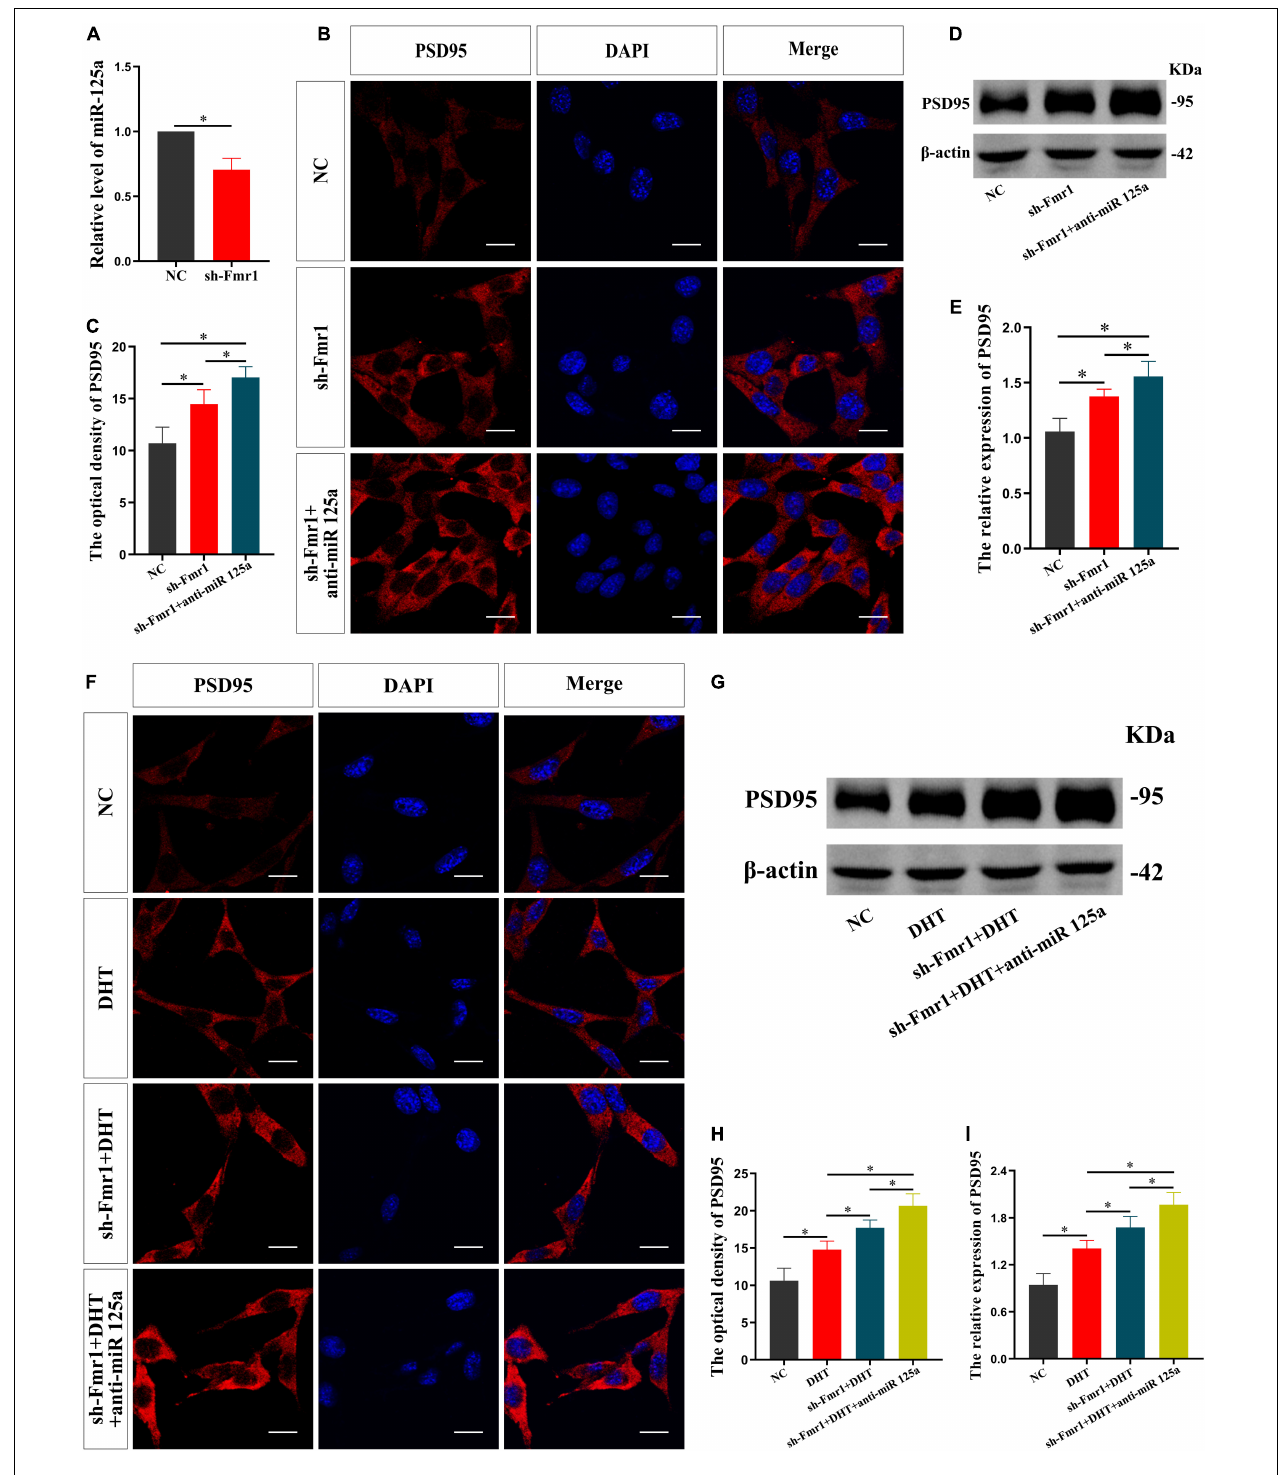
FIGURE 4 | FMRP mediates the effects of DHT on PSD95 through miR-125a in HT22 cells. (A) qRT-PCR for miR-125a induced by FMRP in HT22 cells. (B,C) Immunofluorescence cytochemistry for PSD95 expression in HT22 cells pre-treated with NC or sh-Fmr1 and with NC inhibitor or miR-125a-5p inhibitor. (D,E) Western blotting for PSD95 expression in HT22 cells pre-treated with NC or sh-Fmr1 and NC inhibitor or miR-125a-5p inhibitor. (F , H) Immunofluorescence cytochemistry for PSD95 expression induced by DHT in HT22 cells pre-treated with NC or sh-Fmr1 and with NC inhibitor or miR-125a-5p inhibitor. (G , I) Western blotting for PSD95 expression induced by DHT in HT22 cells pre-treated with NC or sh-Fmr1 and NC inhibitor or miR-125a-5p inhibitor. Scale bars = 20 µ m (* p < 0.05, n = 5).